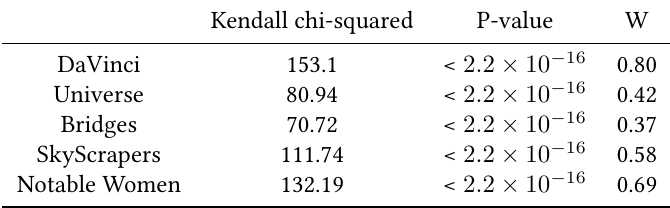
Table 5 Generalized data for calculating the concordance coefficient W for projects